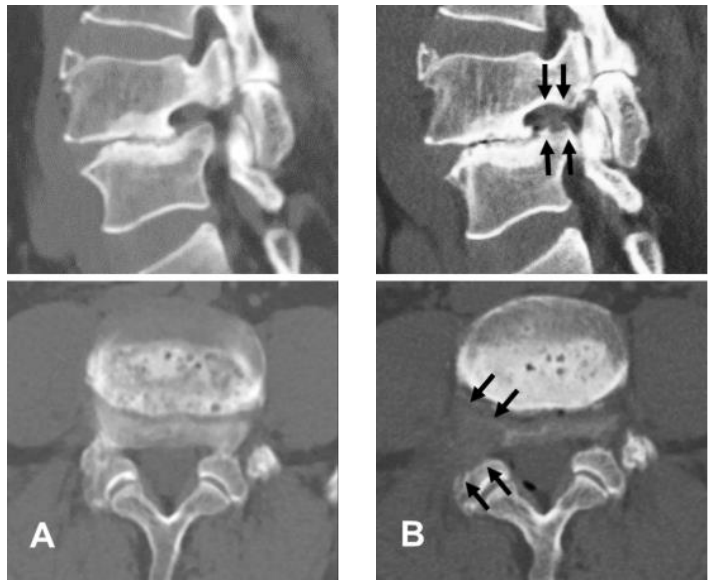
Figure 4. An illustrative case of a 61-year-old male patient. ( A ) Preoperative computed tomography (CT) images showing right-side foraminal stenosis in spondylolisthesis with collapsed disc space at the L4-5 level. ( B ) Postoperative CT images showing foraminal decompression by removal of bony structures, including the lower vertebral endplate and superior articular process (arrows).